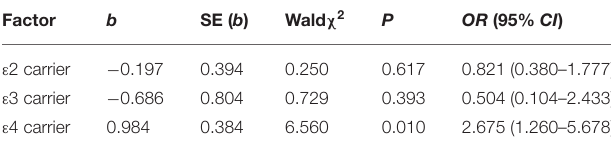
TABLE 4 | Single-factor logistics regression of risk factors for